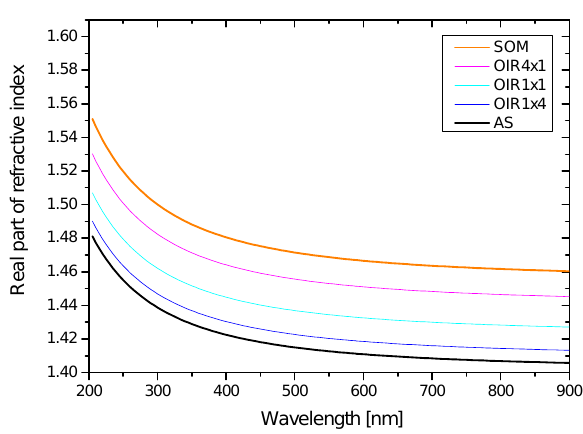
Figure B2. Real part of the refractive index for mixtures of AS and SOM with varying OIRs at 70%RH.